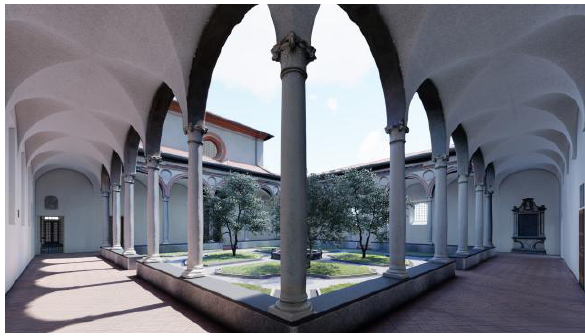
Figure 11. VR experience: The Cloister of the